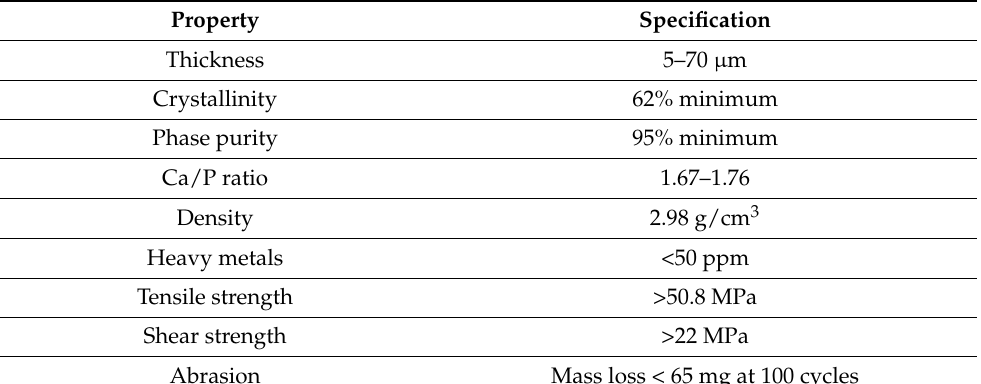
Table 2. HA Coating Requirements